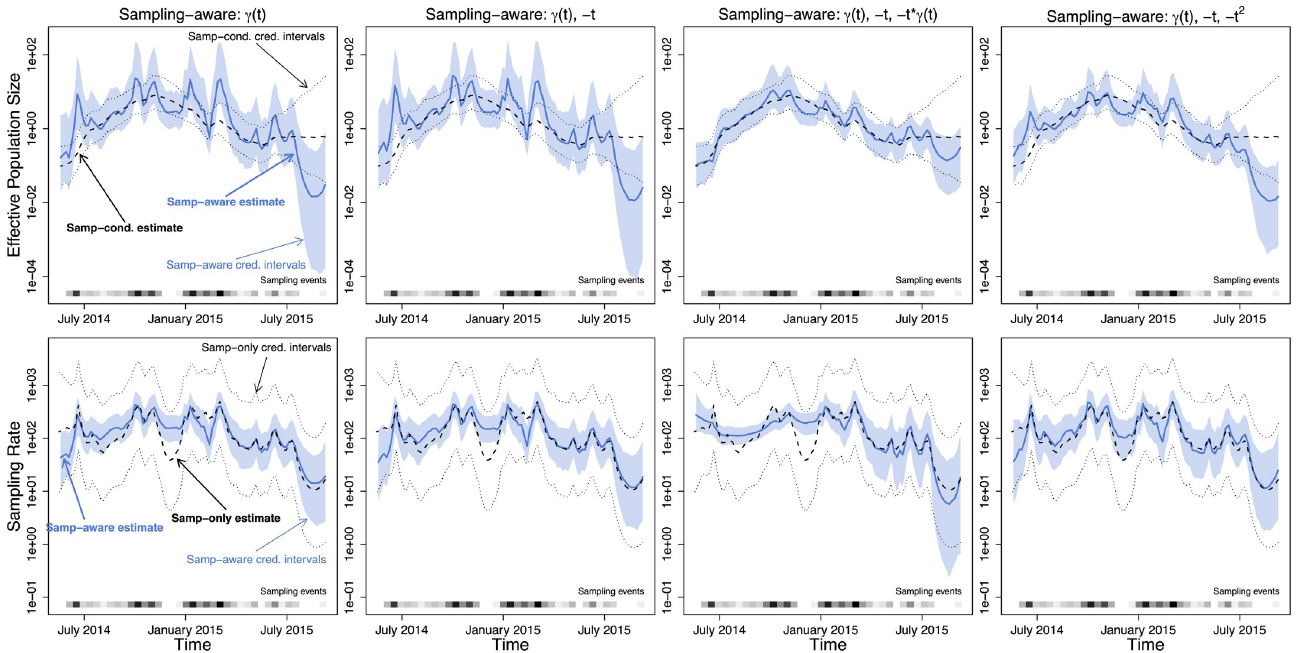
Fig 7. Effective population size and sampling rate reconstructions for the Sierra Leone Ebola dataset. Upper row : Dashed lines and dotted black lines are the pointwise posterior effective population size estimates and credible intervals of the sampling-conditional model. The blue lines and the light blue regions are the pointwise posterior effective population size estimates and credible intervals of that column’s sampling-aware model. Lower row : Dashed lines and dotted black lines are the pointwise posterior sampling rate estimates and credible intervals of a nonparametric sampling-time-only model. The blue lines and the light blue regions are the pointwise posterior sampling rate estimates and credible intervals of that column’s sampling-aware model.